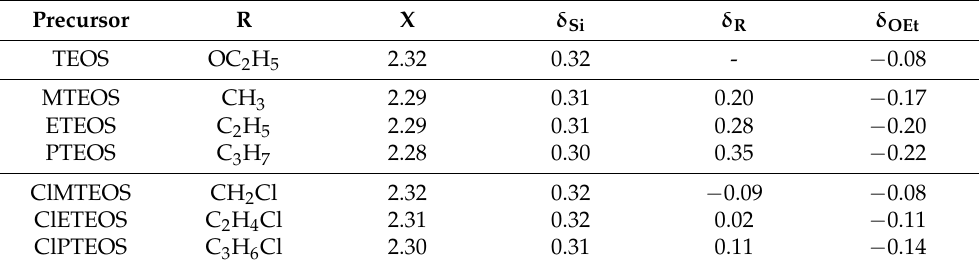
Table 1. Electronegativities and partial charges of the chloroalkyl precursors and their alkyl analogs calculated from the Pauli electronegativities and application of the equations of Livage and Henry